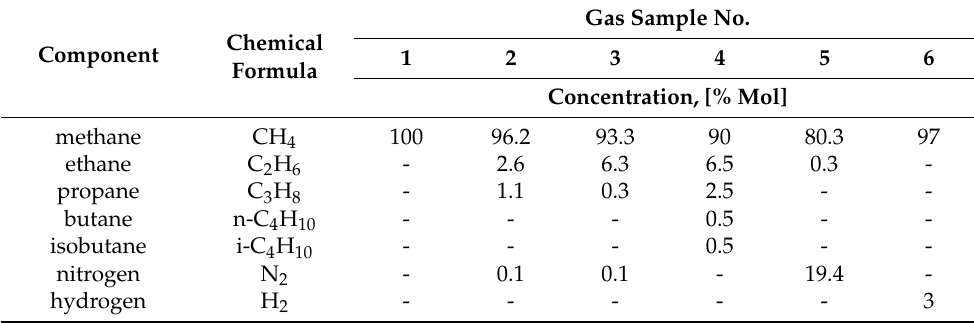
Table 1. Mole fraction of natural gas from various outlet points of the transmission system in Poland (Gas samples 2,3,5) and other gas samples.